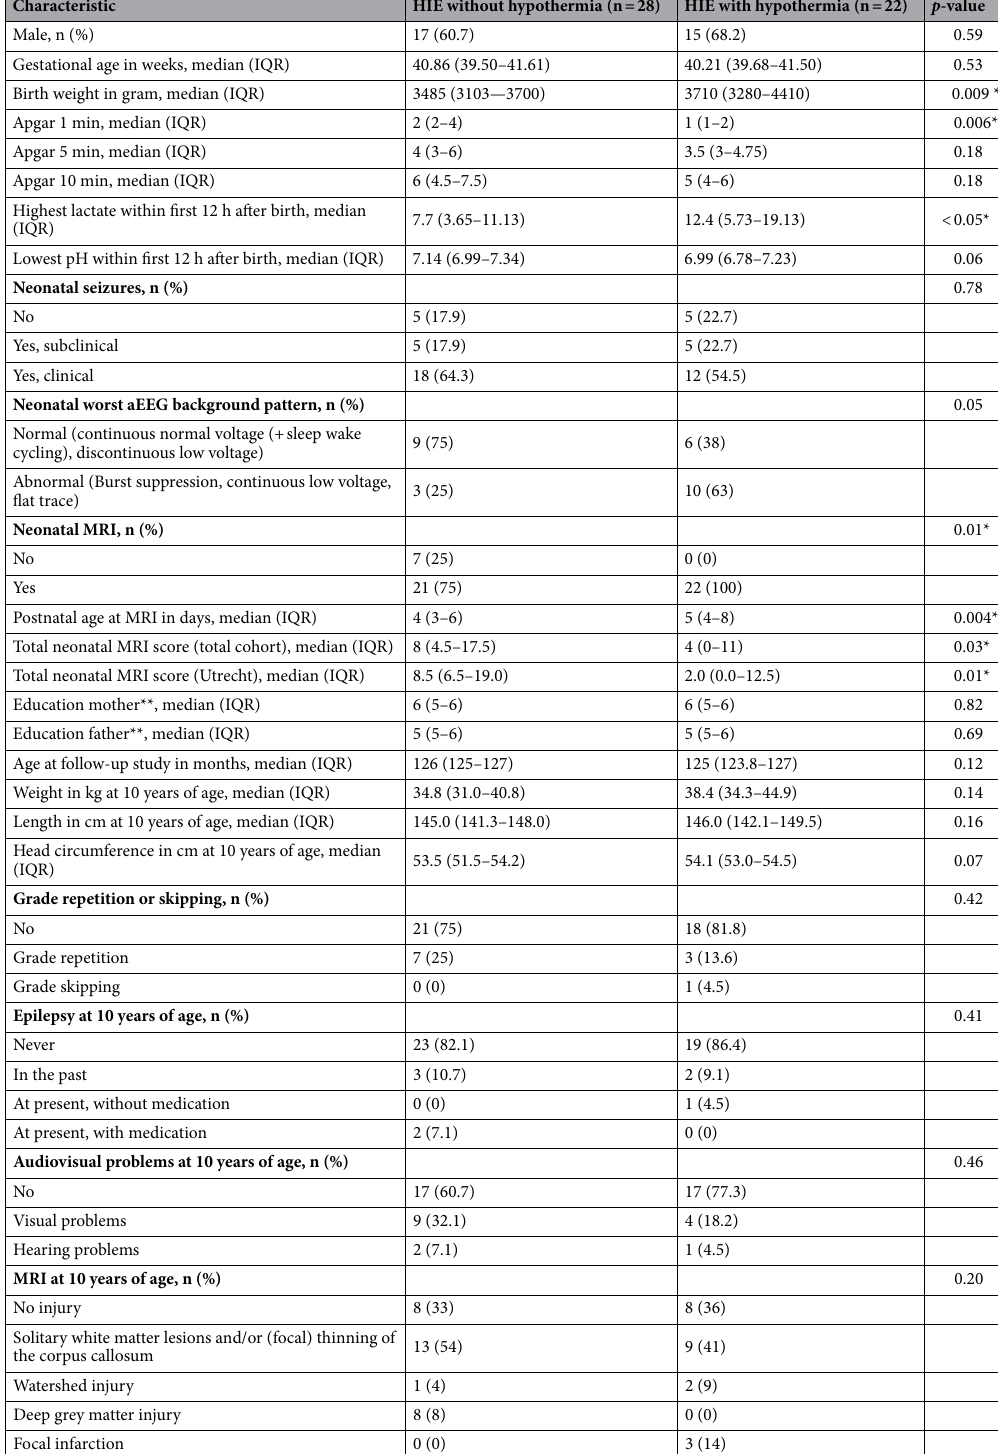
Table 1. Neonatal and childhood characteristics. * p -value < 0.05. **SES according to Verhage